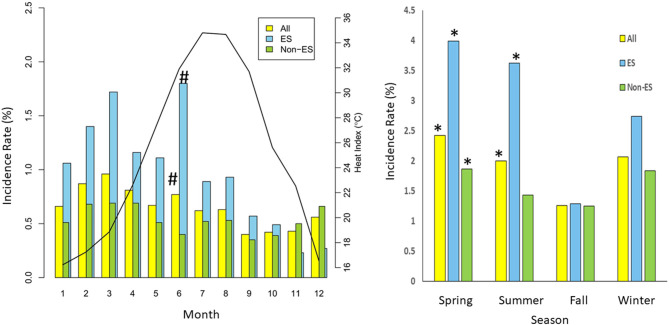
Annual distribution of VTA incidence rate (per person-month) (vertical bar) of 172 patients with ICD (yellow), 45 patients with electrical storm (ES) (blue), and 127 non-ES patients (green). Solid line indicates mean monthly heat index between January 1, 2004, and June 30, 2017. *means P < 0.05 as compared with fall; # means P < 0.05 as compared with reference month.